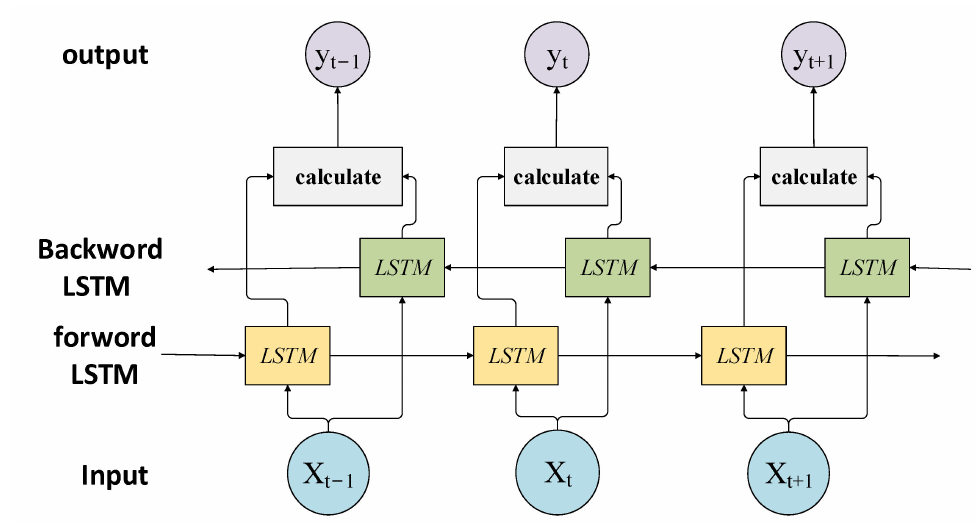
Figure 2. Structure of the BILSTM model.